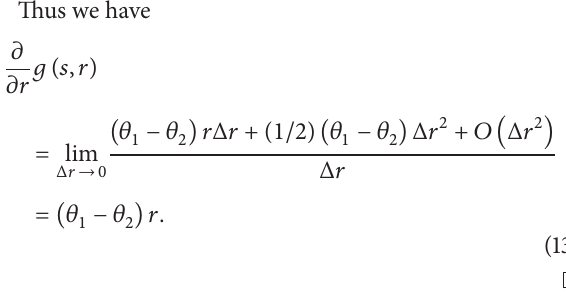
disks corresponding to (𝑠, 𝑟) ∈ ([0, 𝐿] × {̂𝑟}) ∪ ({̂𝑠} × [0, ̂𝑟])